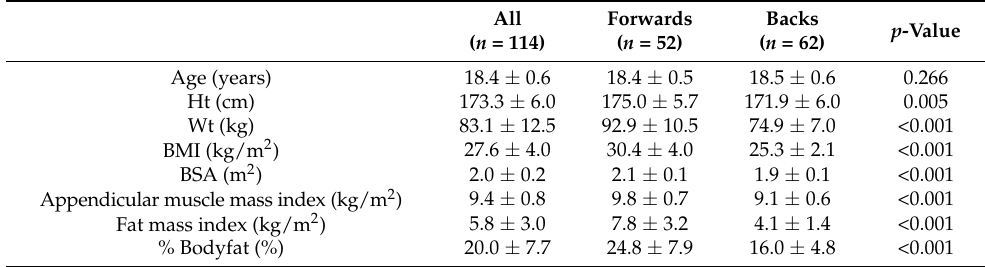
Table 1. Anthropometric data of young Japanese rugby athletes.